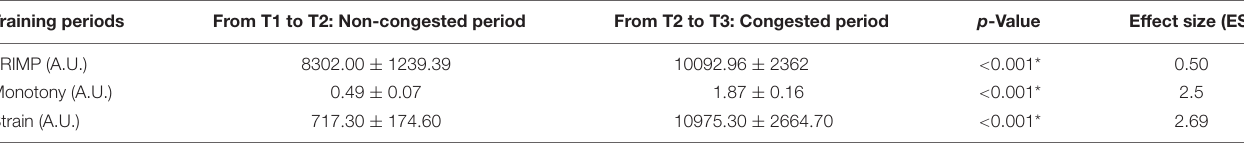
TABLE 3 | Training load parameters during the 12 weeks training period (congested vs. non-congested period of match play). Training periods From T1 to T2: Non-congested period From T2 to T3: Congested period p -Value Effect size (ES) TRIMP (A.U.) 8302 . 00 ± 1239 . 39 10092 . 96 ± 2362 < 0.001* 0.50 Monotony (A.U.) Strain (A.U.) < 0.001* 2.69 Data are presented as means ± SDs. *Significant difference between congested and non-congested period with p < 0.01. TRIMP: Training impulse, A.U: Arbitrary units. TABLE 4 | Changes in physical fitness.